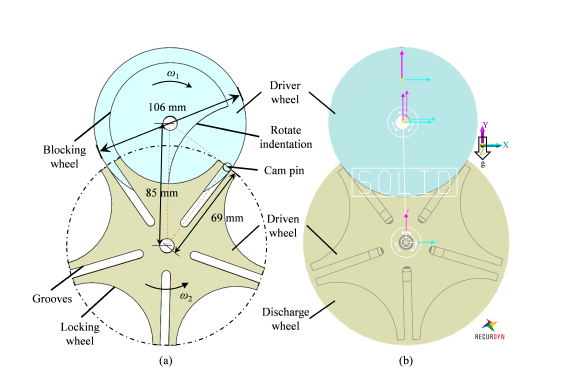
Fig. 2. Model of Geneva mechanism: (a) actual model; (b) simulation model based on RecurDyn.